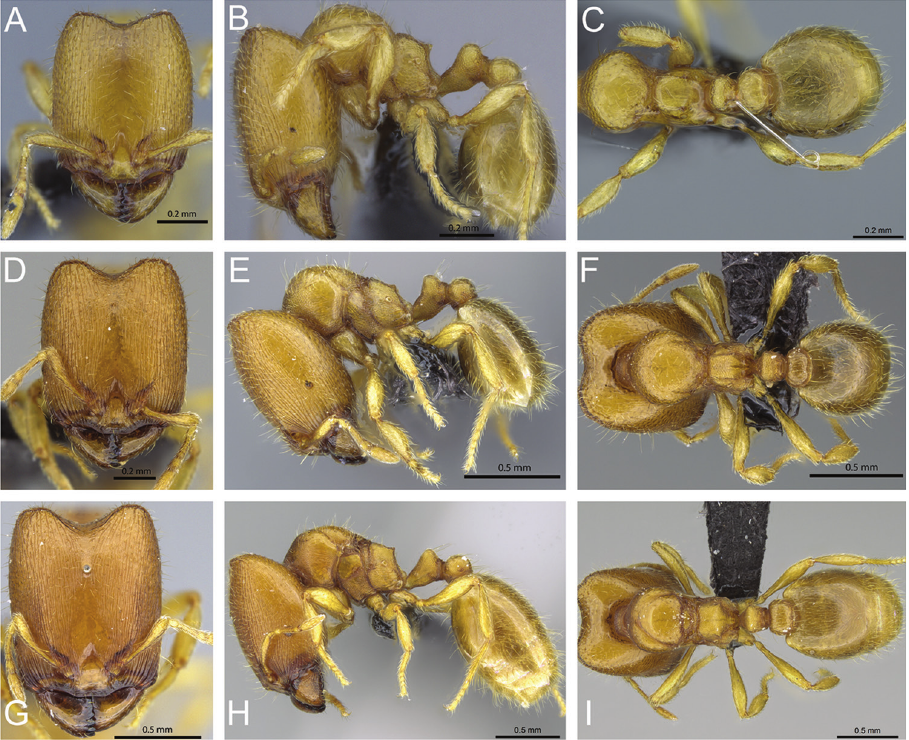
Figure 46. Intermediates of Carebara kabosy . Major workers, CASENT0043272: A head in full-face view B body in profile view C body in dorsal view. CASENT0134199: D head in full-face view E body in profile view F body in dorsal view. CASENT0162282: G head in full-face view H body in profile view I body in dorsal